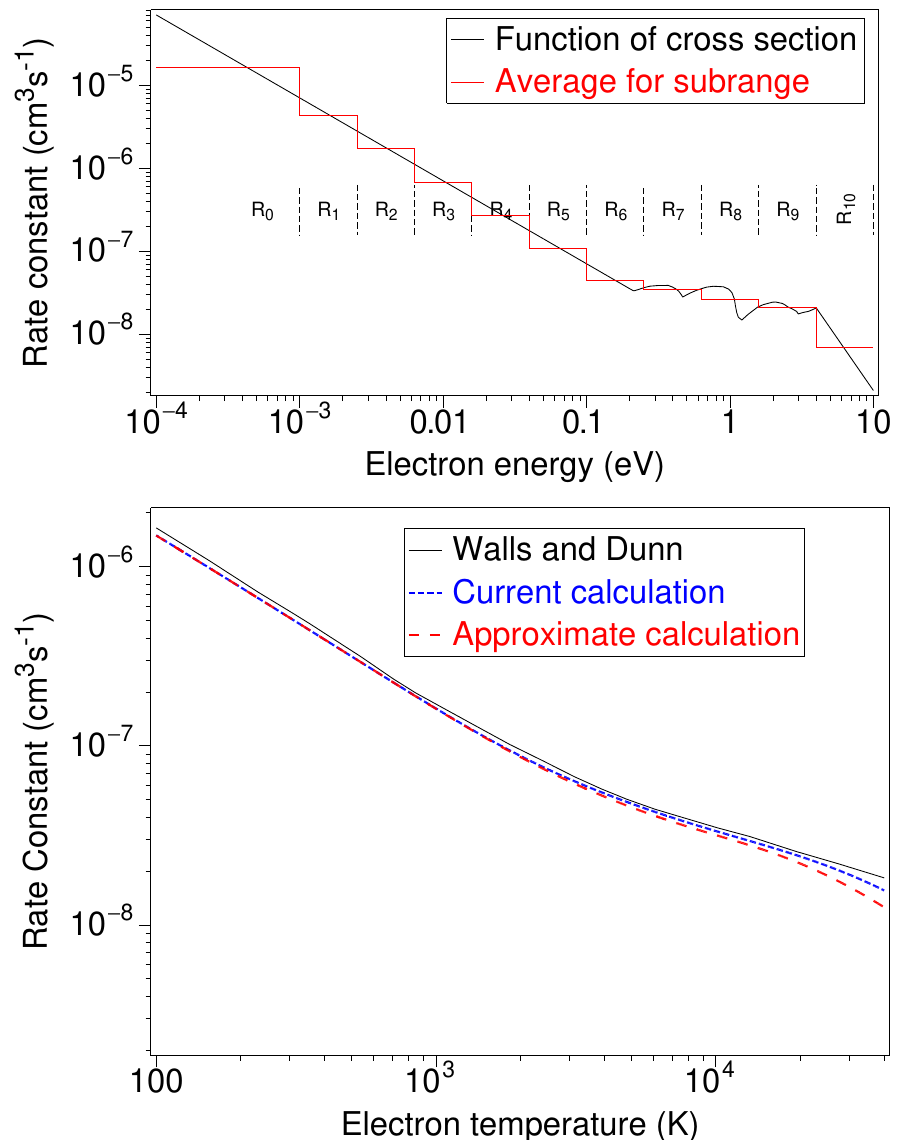
Figure 3. ( upper panel) Rate constants (cm 3 s − 1 ) for the recombination NO + + e − as a function of electron energy (eV), as calculated from the cross sections of Walls and Dunn [19] (curve) and averaged over energy subranges (horizontal segments). ( lower panel) Rate constants for a Maxwellian distribution of electrons as a function of the electron temperature, as given by Walls and Dunn [19] (—–), a current emulation of their calculations (----) and an approximate calculation using the 11 averaged rate constants (– –